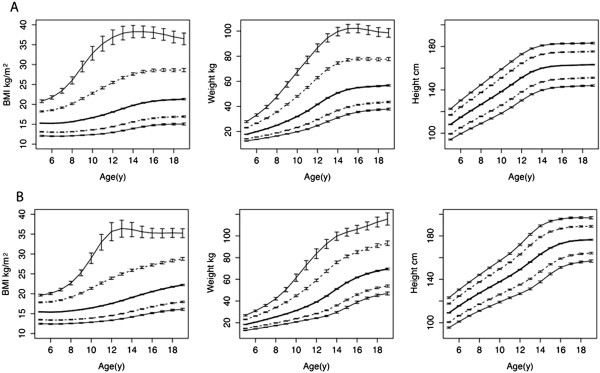
Bootstrap estimates of centile precision: smoothed centiles for girls (A) BMI, weight, and height were first fitted to the original NCHS-R data (N = 11,193). The 95% confidence intervals (CI) were calculated from 1,000 bootstrap samples drawn from the original data with replacement and analyzed in the same way. Each figure displays centiles 0.135, 3, 50, 97, and 99.9, with error bars to denote the corresponding 95% CI at yearly intervals from 5–19y. Similarly, boys (B) BMI, weight, and height centiles were fitted to data on 11,106 boys and CI calculated from the analysis of 1,000 bootstrap replicates.